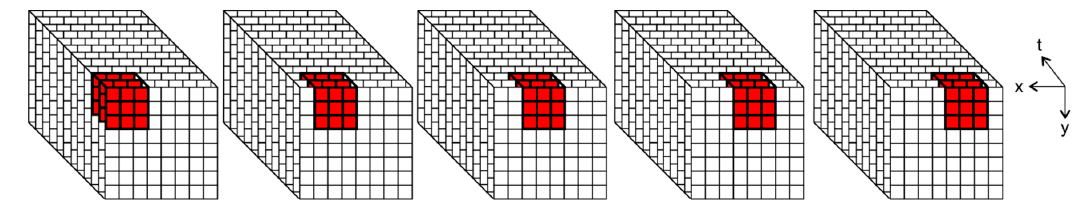
Figure 3. 3D convolutional filter considering a time series data with spatial dimensions “x” and “y” and temporal dimension